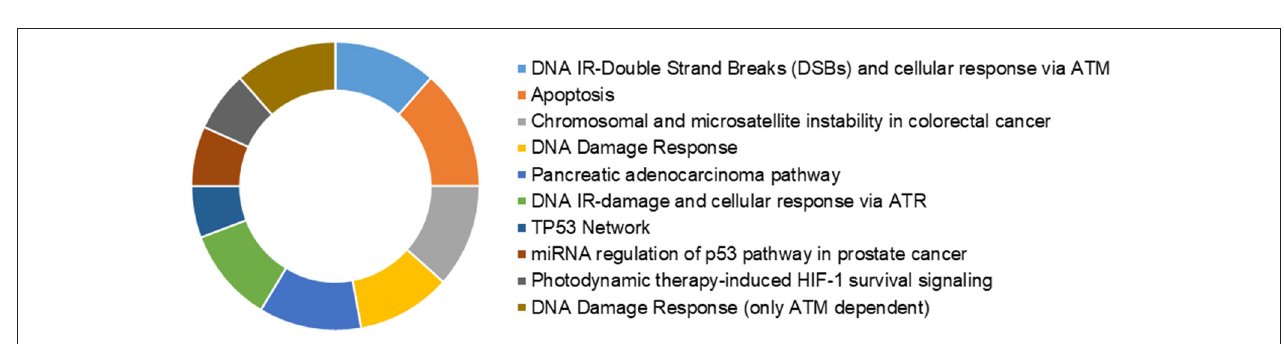
FIGURE 4 | Donut chart depicting the over-represented cancer-relevant pathways across the 88 common